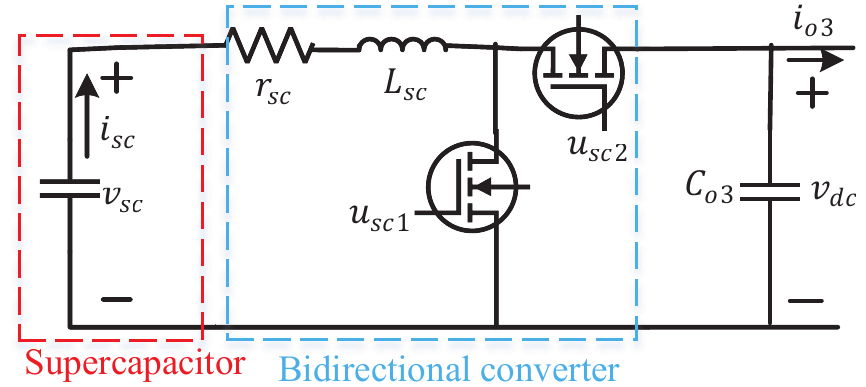
Figure 4. Equivalent circuit representation of a supercapacitor coupled to a bidirectional DC–DC